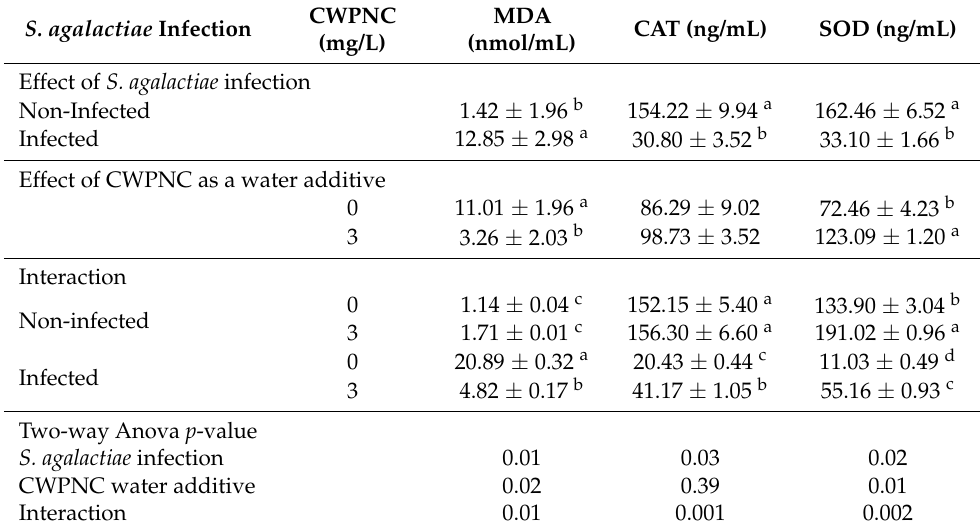
Table 5. Effect of S. agalactiae infection and/or CWPNC as water exposure on oxidant/antioxidant biomarkers of O. niloticus for seven days.